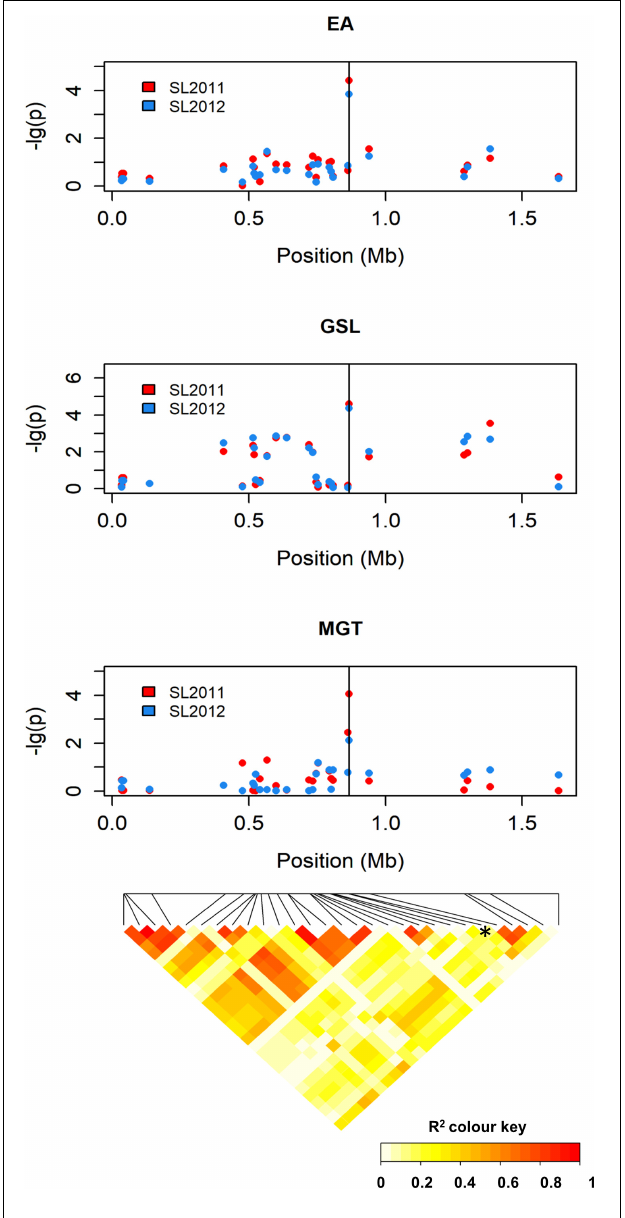
FIGURE 7 | Manhattan plot describing genome-wide marker–trait associations for the traits seed erucic acid content, seed glucosinolate content, and mean germination time around peak marker Bn-A01-p26914512 on chromosome A9 and heatmap showing the corresponding chromosome-wide correlations ( r 2 ) between SNP markers.